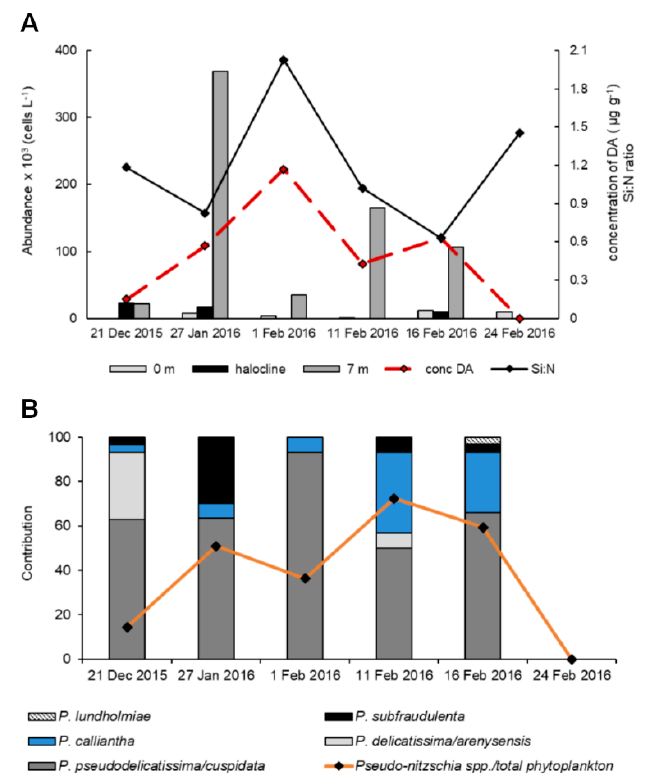
Figure 7. ( A ) Abundance of Pseudo-nitzschia spp. observed by LM at three sampling depths and the concentration of domoic acid determined in shellfish with Si:N ratio in layer at 7 m depth; ( B ) contribution of Pseudo-nitzschia species to phytoplankton net samples, analysed with SEM during a shellfish toxicity period and contribution of Pseudo-nitzschia spp. to total phytoplankton abundance.